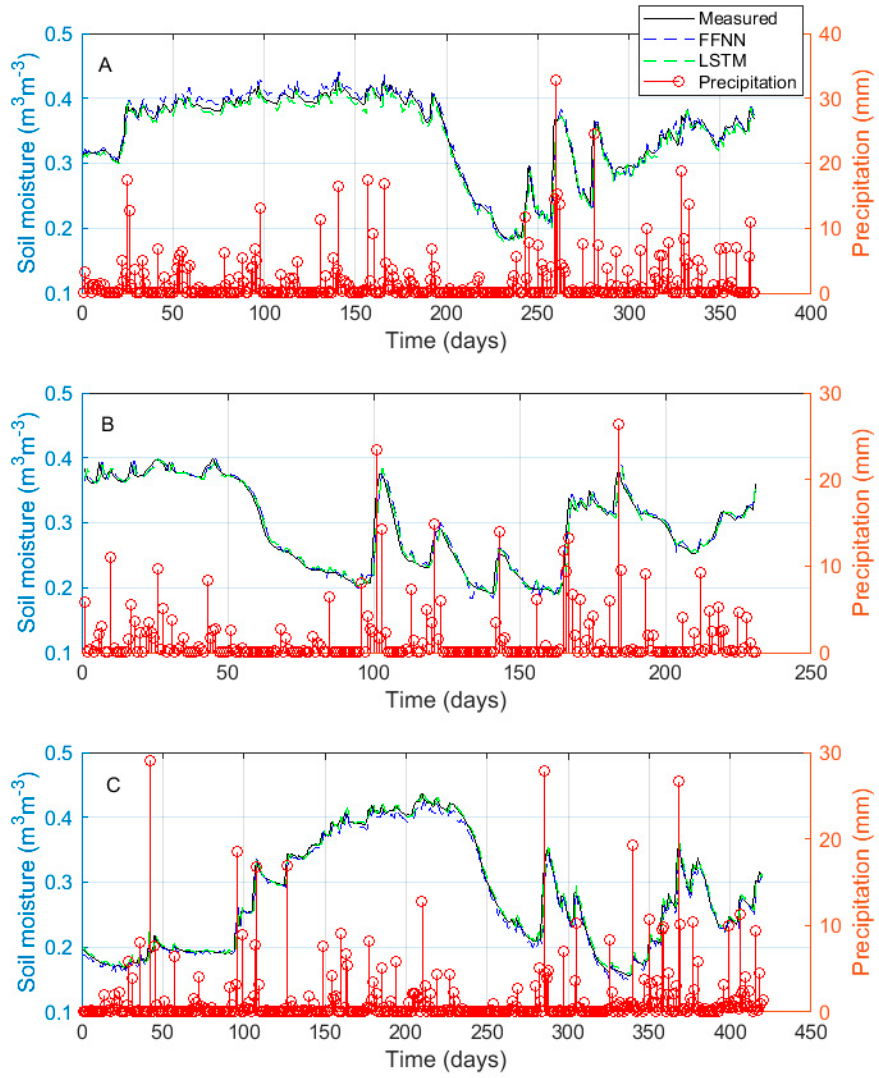
Figure 6. Measured soil moisture content and soil moisture content predicted by the FFNN and the LSTM using the evaluation dataset for the three training sites, ( A ) Baluderry, ( B ) Stoughton, and ( C ) Waddeston.